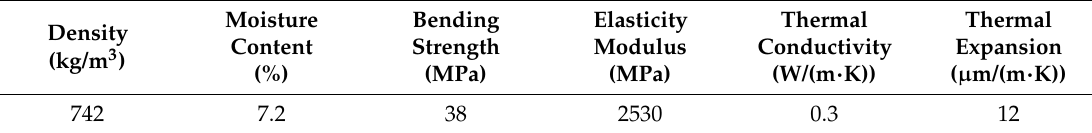
Table 1. Selected mechanical and physical properties of medium density fiberboard (MDF).